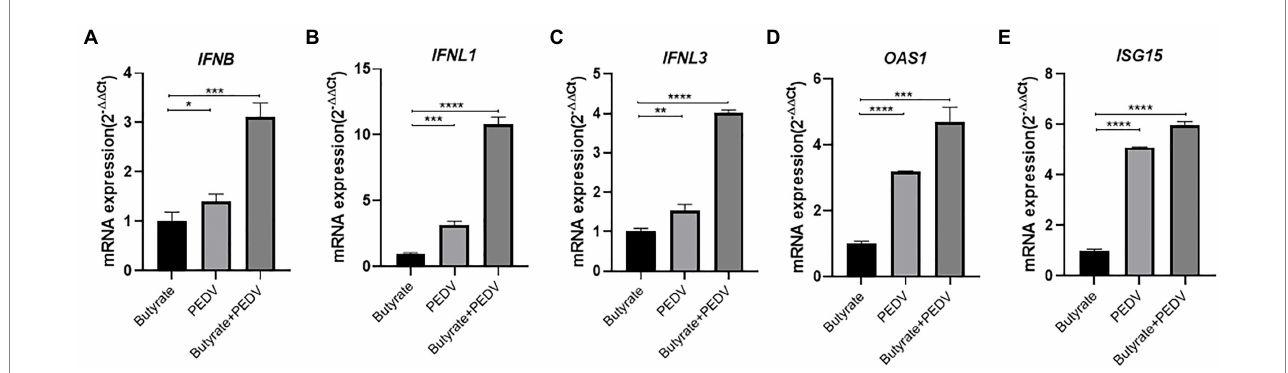
FIGURE 2 Butyrate treatment mediates an IFN response and ISG expression in PEDV-infected IPEC-J2 cells. (A) IFNB expression in butyrate-treated and PEDV- infected IPEC-J2 cells after 24 h. (B) IFNL1 expression in butyrate-treated and PEDV-infected IPEC-J2 cells after 24 h. (C) IFNL3 expression in butyrate- treated and PEDV-infected IPEC-J2 cells after 24 h. (D) OAS1 expression in butyrate-treated and PEDV-infected IPEC-J2 cells after 24 h. (E) ISG15 expression in butyrate-treated and PEDV-infected IPEC-J2 cells after 24 h.